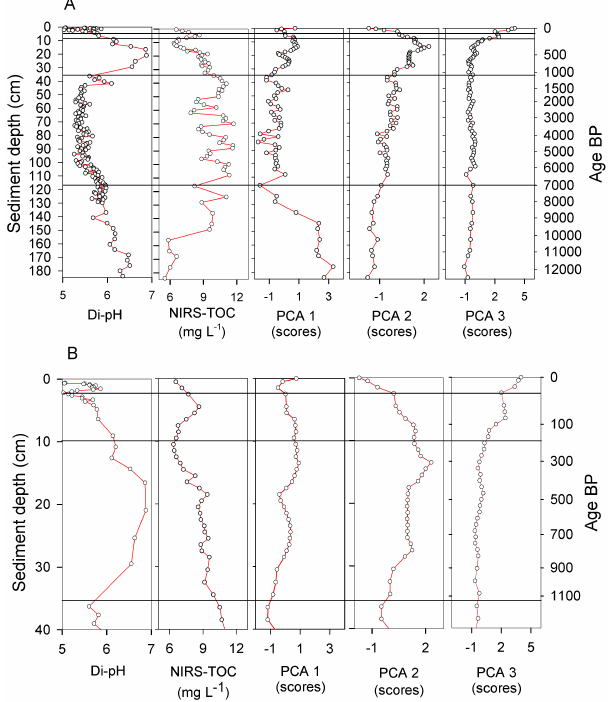
Fig. 4. Diatom inferred pH, NIRS inferred TOC and scores from a principal component analysis (PCA) summarizing the inferred lake- water TOC and geochemistry data into three significant components along (A) the entire Holocene (B) up-scaling of the past 1200 years. The PC 1-3 captured 46, 21 and 20% of the total variance, respec- tively.